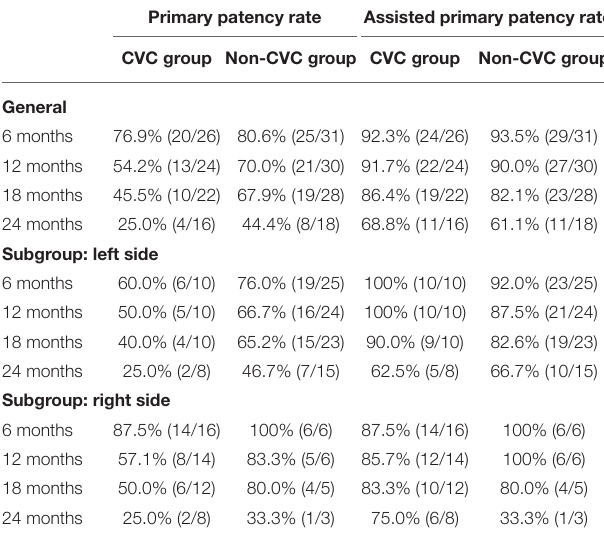
CVC group: patients with previous hemodialysis catheter placement in ipsilateral upper extremity; Non-CVC group: patients without previous hemodialysis catheter placement in ipsilateral upper extremity.